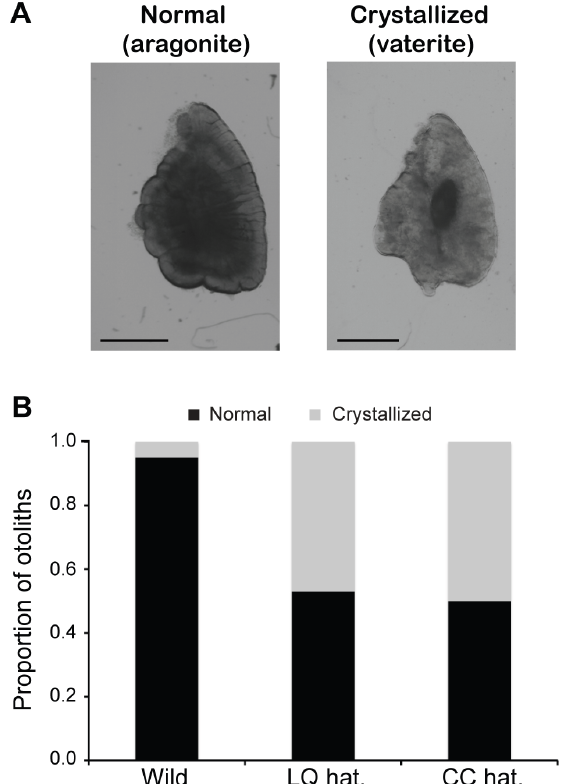
Figure 3. Sagittal otolith calcium carbonate composition. Transmitted light images of a normal (aragonite) sagitta from a wild- origin juvenile (left) and a crystallized (vaterite) sagitta from a Cook Creek hatchery fish (right). Scale bars in each image = 1 mm. (B) Relative proportion of aragonite (black) and vaterite (gray) sagittae in fish from each population (wild n =20 otoliths (10 fish 6 2 otoliths each), Cook Creek=28 otoliths, Lake Quinault=34 otoliths). Both groups of hatchery fish had a significantly higher proportion of crystallized otoliths than wild fish (Chi-square tests, p =0.001).